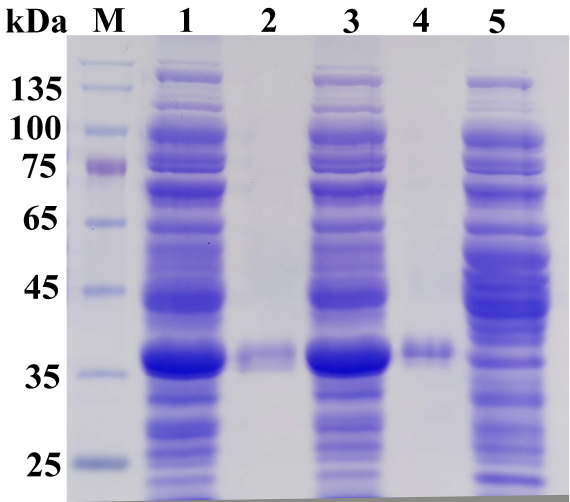
Figure 3. SDS-PAGE analysis of Est19 and E154D variant. Lane M, protein molecular mass marker; Lanes 1 and 3, total protein from E. coli with IPTG induction of Est19 and E154D variant, respectively; Lane 2, purified Est19; Lane 4, purified E154D variant; Lane 5, negative control, total protein from E. coli without IPTG